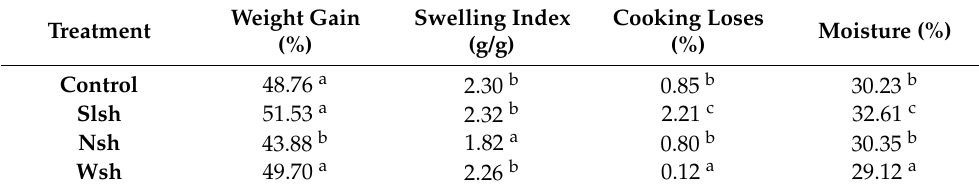
Table 3. Values of technological properties for each pasta analyzed.